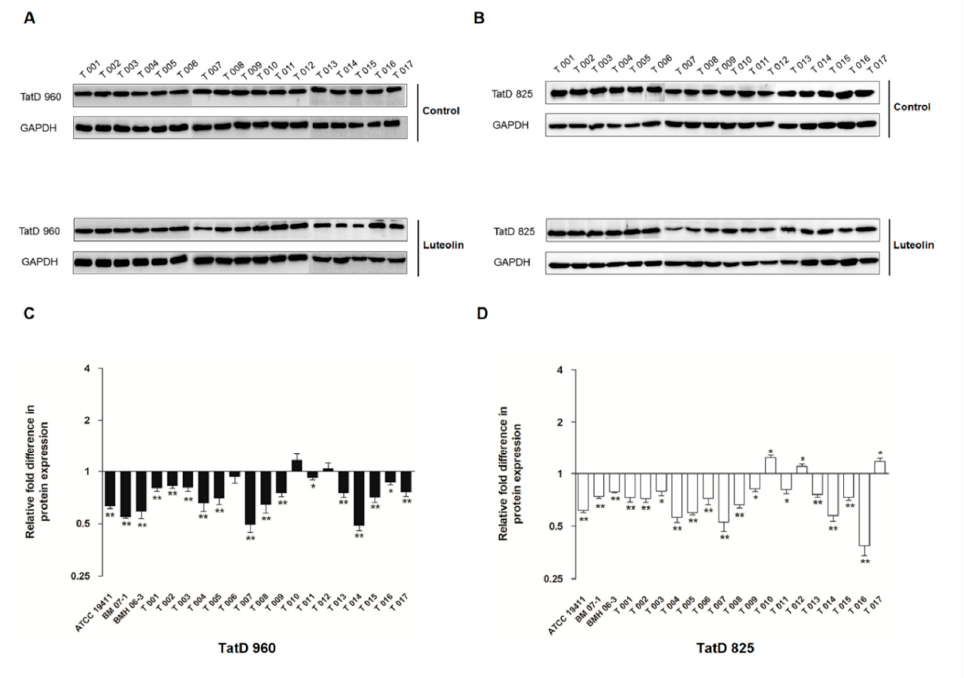
Figure 5. The effect of luteolin on the expression of TatD DNases in 20 T. pyogenes . ( A , B ) Western blot results TatD DNases in T . pyogenes (T001–T017) with different treatment, ( C ) the expression of TatD960, ( D ) the expression of TatD825. T . pyogenes treated with luteolin at 1/2 MIC. Data were presented as means ± SD. (* compared with control, * p < 0.05, ** p < 0.01).